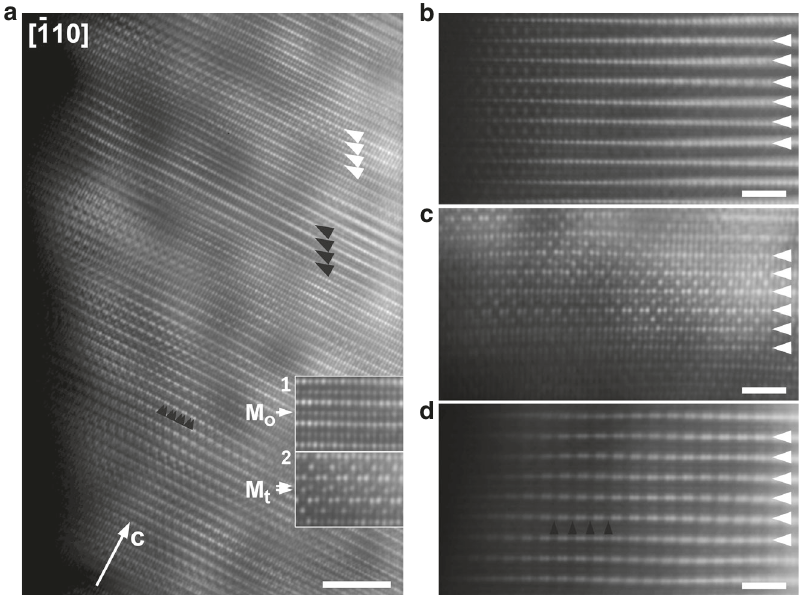
Fig. 2 Local structure of Li-rich NMCs viewed with HAADF-STEM images. a Overview [ (cid:1) 1 1 0] HAADF-STEM image showing structural inhomogeneity of the A ′ phase. Scale bar indicates 1 nm. The Li 1 − x M 2 + x layers are visible as rows of brighter dots perpendicular to the c -axis. “ Honeycomb ” Li-M ordering is visualized by pairs of bright dots with ~0.14 nm interdot separation (such as marked with pairs of small black arrowheads). The Li 1 − x M 2 + x layers with pertaining “ honeycomb ” ordering (such as marked with large white arrowheads) alternate with the layers where this ordering is largely suppressed (such as marked with large black arrowheads). The interlayer spaces demonstrate pronounced HAADF intensity indicating migration of the M cations to either octahedral sites M o (see inset 1) or to the tetrahedral interstices M t (see inset 2, see Supplementary Fig. 8 for atomic position assignment). This migration occurs at the near-surface region as well (at >15 nm away from the surface). Near-surface [ (cid:1) 1 1 0] HAADF-STEM images of Li-rich NMC charged to 4.6 V ( b , the A phase), 4.8 V ( c , the A ′ phase) and discharged to 2.0 V ( d ), scale bars indicate 1 nm. The M cation migration sets in at very thin 1 – 2 nm surface layer in the A phase, then it becomes very pronounced in the A ′ phase and fi nally gets almost fully suppressed after 2.0 V discharge. The “ honeycomb ” Li- M ordering is largely restored in the discharged phase as demonstrated by the pattern of the bright dot pairs, but some disorder still remains indicated by residual intensity between the dot pairs (marked with black arrowheads in c ).